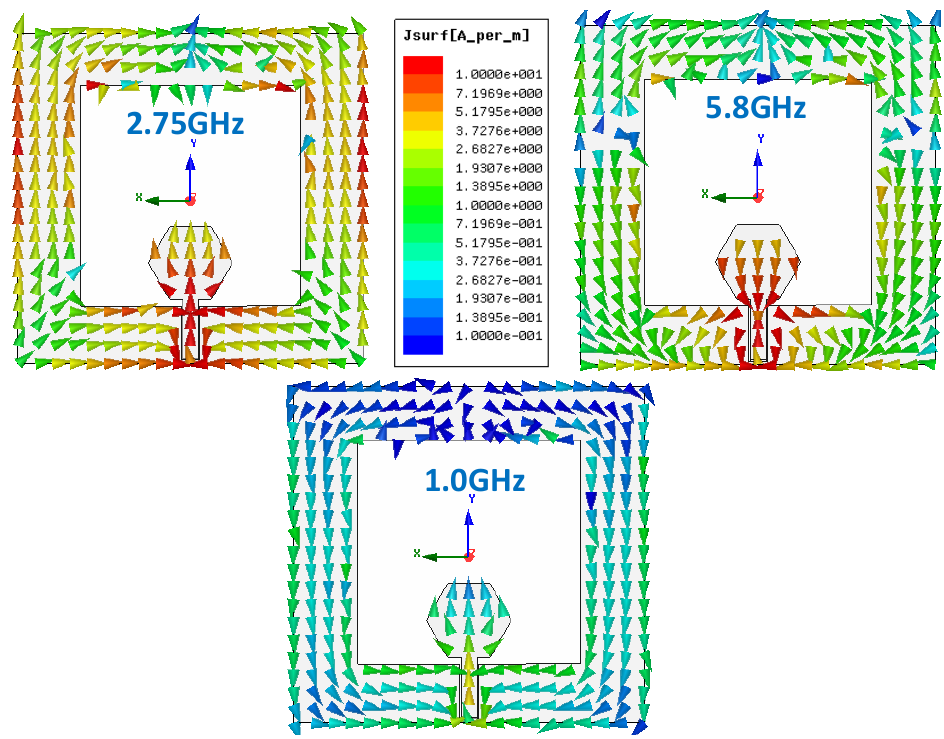
Figure 4. Surface current distribution for the CPW-fed slot monopole at two operative frequencies: 2.75 GHz and 5.8 GHz, and at a not properly matched (non-operative) frequency: 1 GHz.